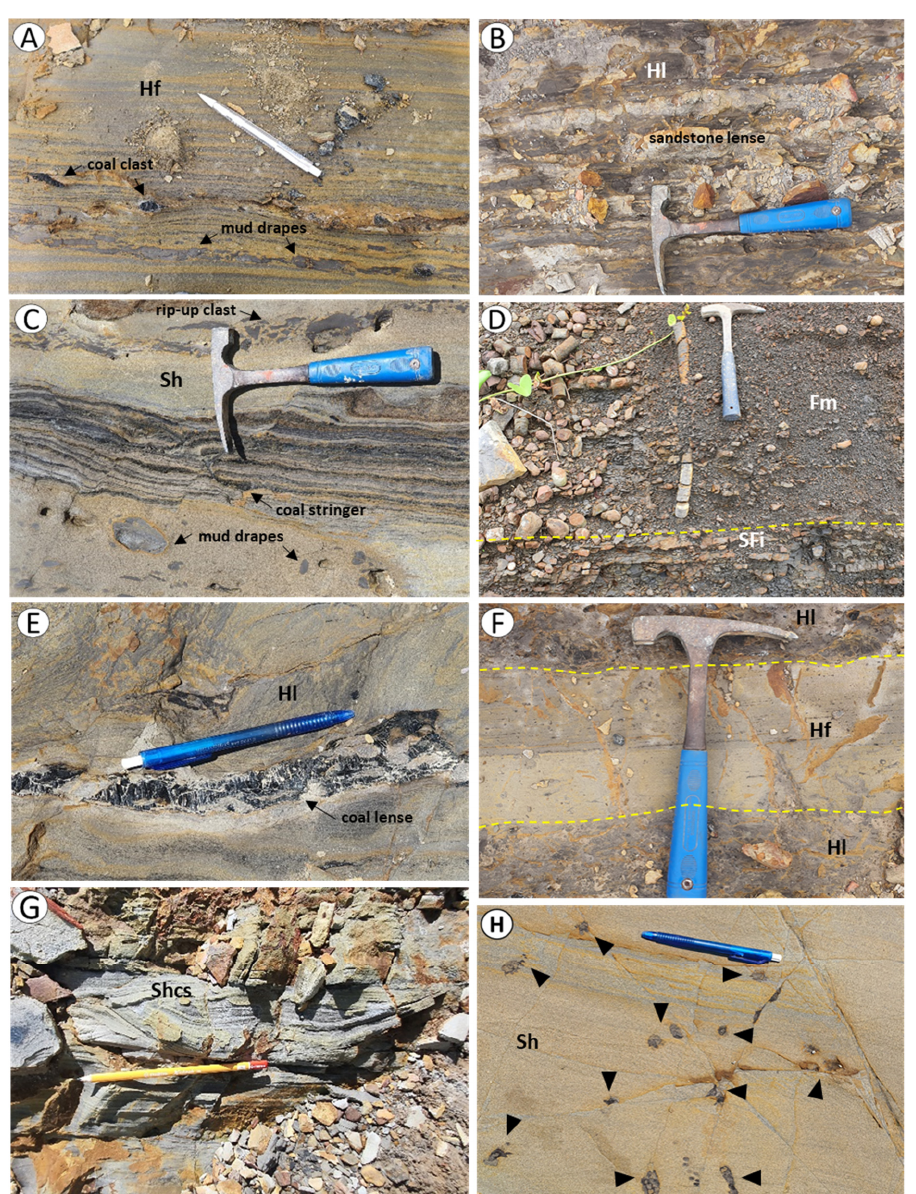
Figure 7. ( A ) Heterolithic flaser facies (Hf) with mud drapes and localized coal clast in outcrop TJ06. ( B ) Heterolithic lenticular facies (Hl) was observed in outcrop TJ04. ( C ) Laminated carbonaceous materials, thin coal stringers with mud, and rip-up clasts were observed in horizontal laminated sandstone facies of outcrop TJ06. ( D ) Vertical Skolithos trace fossil observed in outcrop TJ03. ( E ) Extensive coal lenses within heterolithic lenticular facies in outcrop TJ06. ( F ) Sharp to gradational contact of interbedded heterolithic flaser (light) and lenticular (dark) facies (Sfl). ( G ) Small-scale hummocky-cross stratification in sandstone (Shcs) found in outcrop TJ04. ( H ) Patches of Ophiomorpha trace fossils within the sandstone facies were observed in outcrop TJ08.